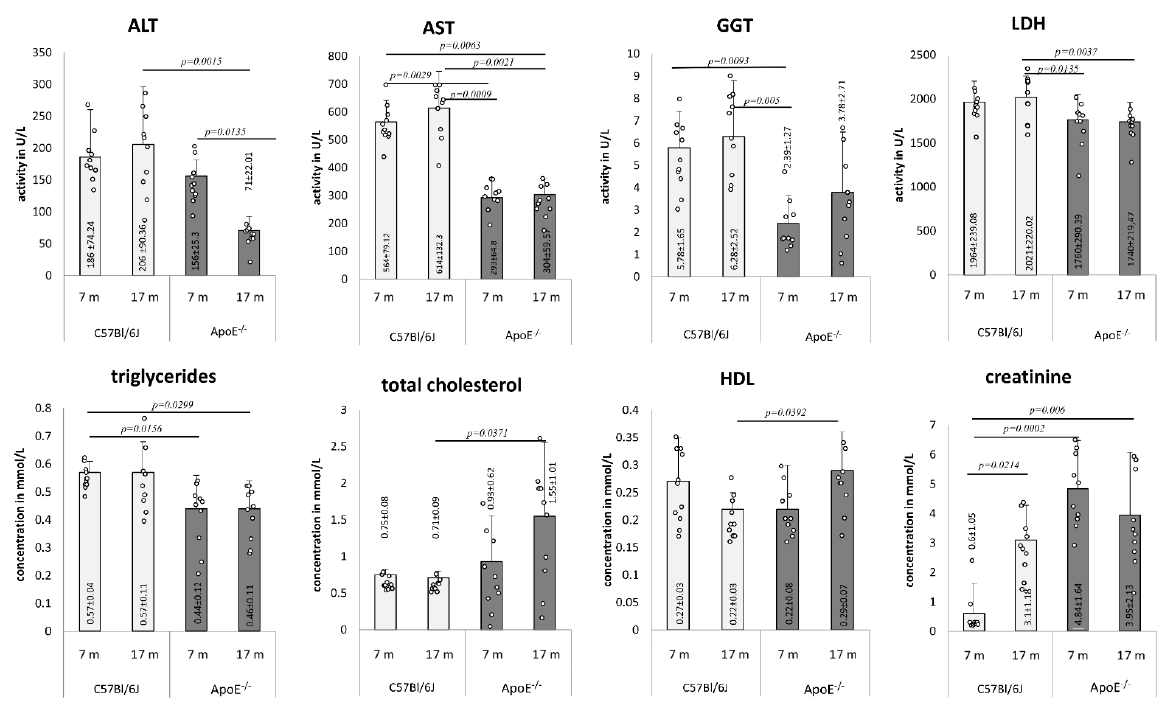
Figure 8. Age-related changes in mice blood parameters. Serum biochemical analysis in 7- and 17-month-old C57Bl/6J and ApoE −/− mice. Data were analyzed by two-way Kruskal–Wallis test (the exact F values for genotype and age for alanine transaminase (ALT) are 4.86 and 0.43, for aspartate transaminase (AST) are 70.24 and 0.95, for γ-glutamyl transferase (GGT) are 13.48 and 1.54, for lactate dehydrogenase (LDH) are 11.98 and 3.97, for triglycerides are 9.72 and 0.03, for total cholesterol are 6.14 and 2.2, for HDL are 0.07 and 0.07, and for creatinine are 19.21 and 1.66, respectively) followed by Dunn’s multiple comparison post-hoc test. Shown are the means ± standard deviations. The significance of differences between compared groups are marked with obtained p -values ( p ) for each significant comparison; the different genotype groups were not littermates; row data are depicted by circles; m–months.